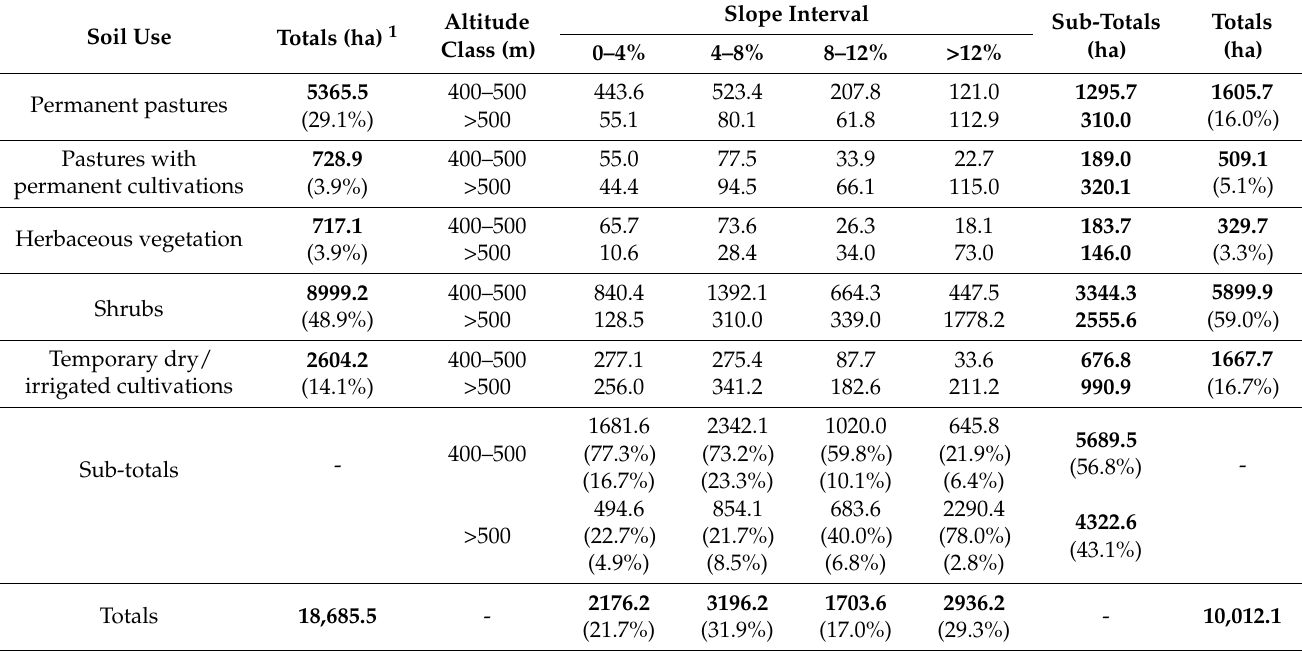
Table 3. Available areas (ha) of five soil uses at two altitude classes and four slope intervals, and percentages to total area. Soil